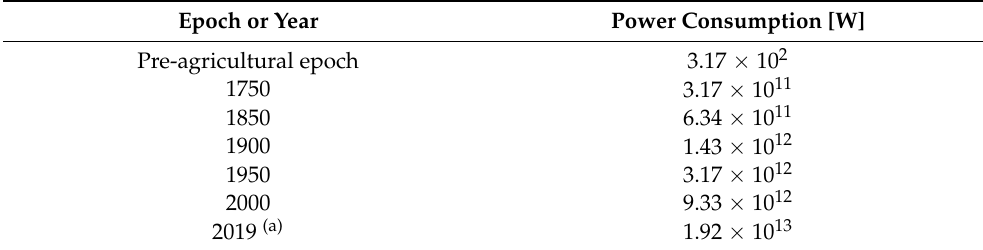
Table 2. Global power (expressed in Watts) for different epochs or years (Data extracted from [50]; (a) is derived from IEA official statistics, available from IEA website). Epoch or Year